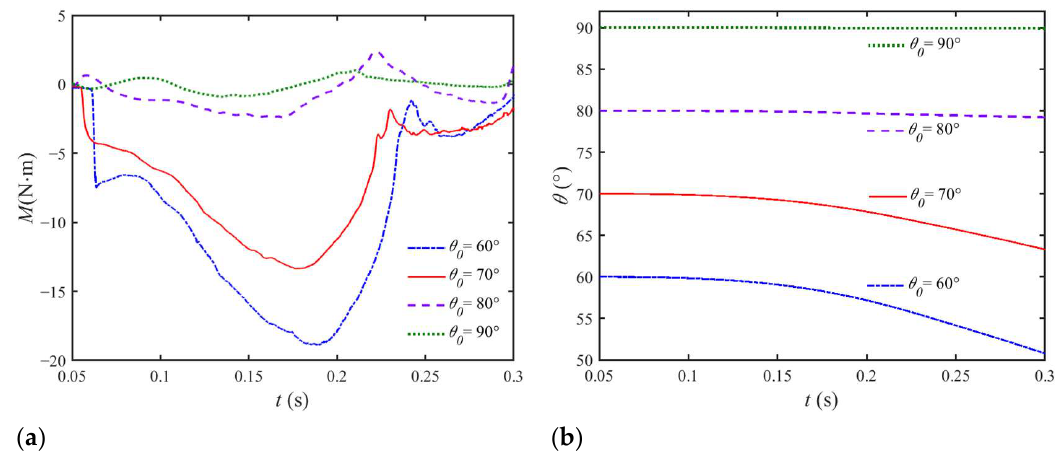
Figure 17. Free surface profiles of the vehicle entering water at θ 0 = 80° at different times: ( a ) t = 0.10 s, ( b ) t = 0.15 s, ( c ) t = 0.20 s, ( d ) t = 0.25 s, and ( e ) t = 0.30 s.